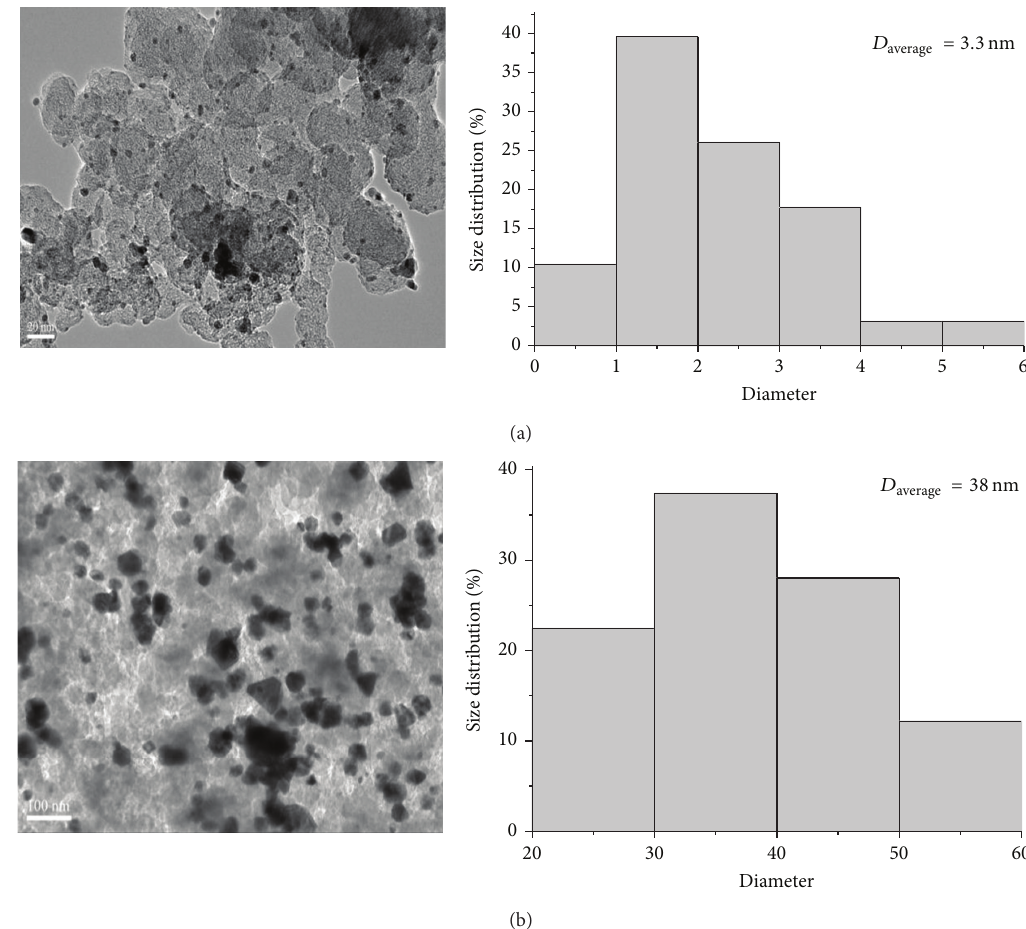
Figure 1: TEM images and particle size distributions of Pd/C (NaBH 4 ) (a) and Pd/C (NaH 2 PO 2 ) (b).